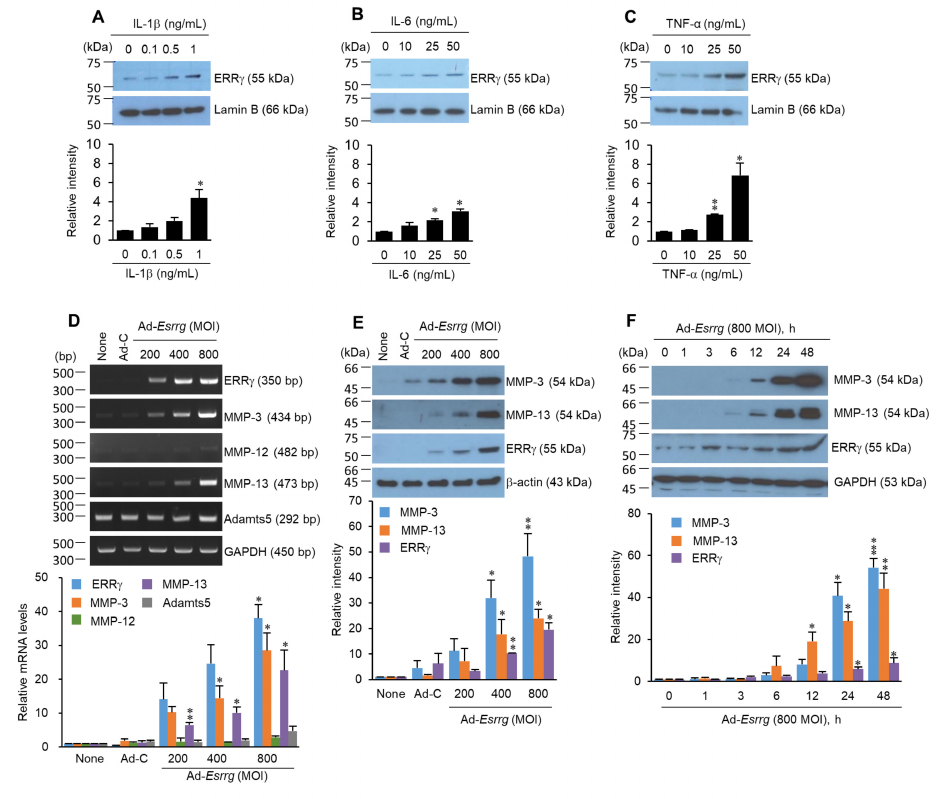
Figure 2. ERR γ is an inducer of MMP-3 and MMP-13 in articular chondrocytes. Primary cultured articular chondrocytes were exposed to IL-1 β (0–1 ng / mL) ( A ), IL-6 (0–50 ng / mL) ( B ), and TNF- α (0–50 ng / mL) ( C ) for 24 h. ERR γ protein levels were quantified by Western blotting. ( D ) mRNA levels of ERR γ and catabolic factors (MMP-3, MMP-12, MMP-13, and ADAMTS5) were analyzed by RT-PCR and qRT-PCR in primary cultured chondrocytes infected with Ad- C (800 MOI) or the indicated MOI of Ad- Esrrg for 36 h. ( E ) The protein levels of ERR γ , MMP-3, and MMP-13 were analyzed by Western blot with semi-quantification in primary cultured chondrocytes infected with Ad- C (800 MOI) or the indicated MOI of Ad- Esrrg for 36 h. ( F ) The protein levels of ERR γ , MMP-3, and MMP-13 were analyzed by Western blotting with semi-quantification in primary cultured chondrocytes infected with Ad- Esrrg (800 MOI) for the indicated hours. The results are representative of three independent experiments from di ff erent pups. Values are presented as mean ± SEM (* p < 0.05, ** p < 0.01, and *** p < 0.001). One-way ANOVA. GAPDH, β -actin, and Lamin B were used as internal markers. ERR γ , estrogen-related receptor γ ; IL-1 β , interleukin-1 β , IL-6, interleukin 6; TNF- α , tumor necrosis factor- α ; MOI, multiplicity of infection; MMP-3, matrix metalloproteinase-3; MMP-13, matrix